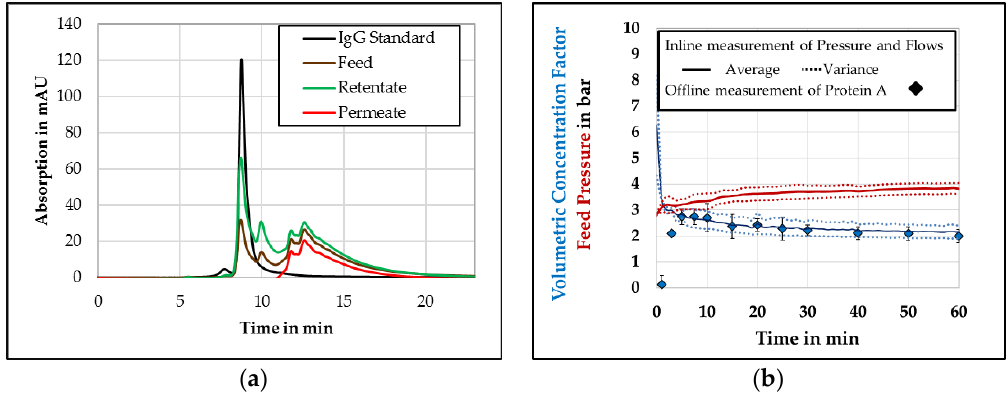
Figure 9. ( a ) Size exclusion chromatography analysis. ( b ) Development of volumetric concentration factor and feed pressure during experiments.